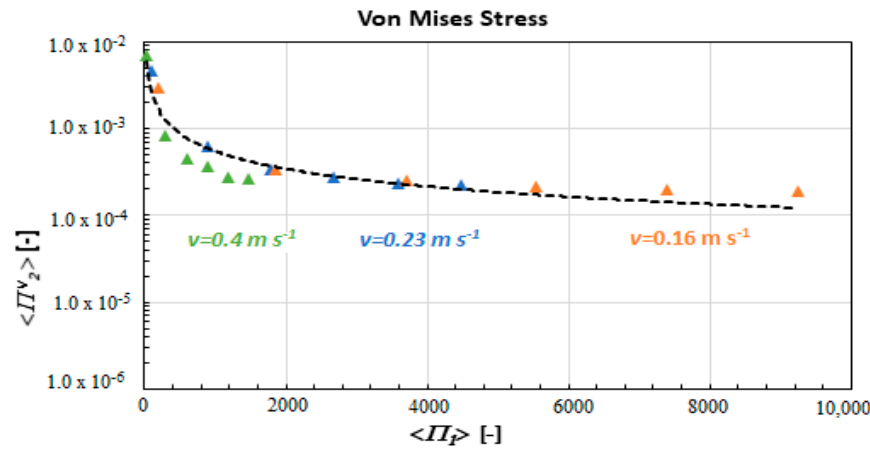
Figure 6. Relationship between average stress < Π V 2 > and < Π 1 >.